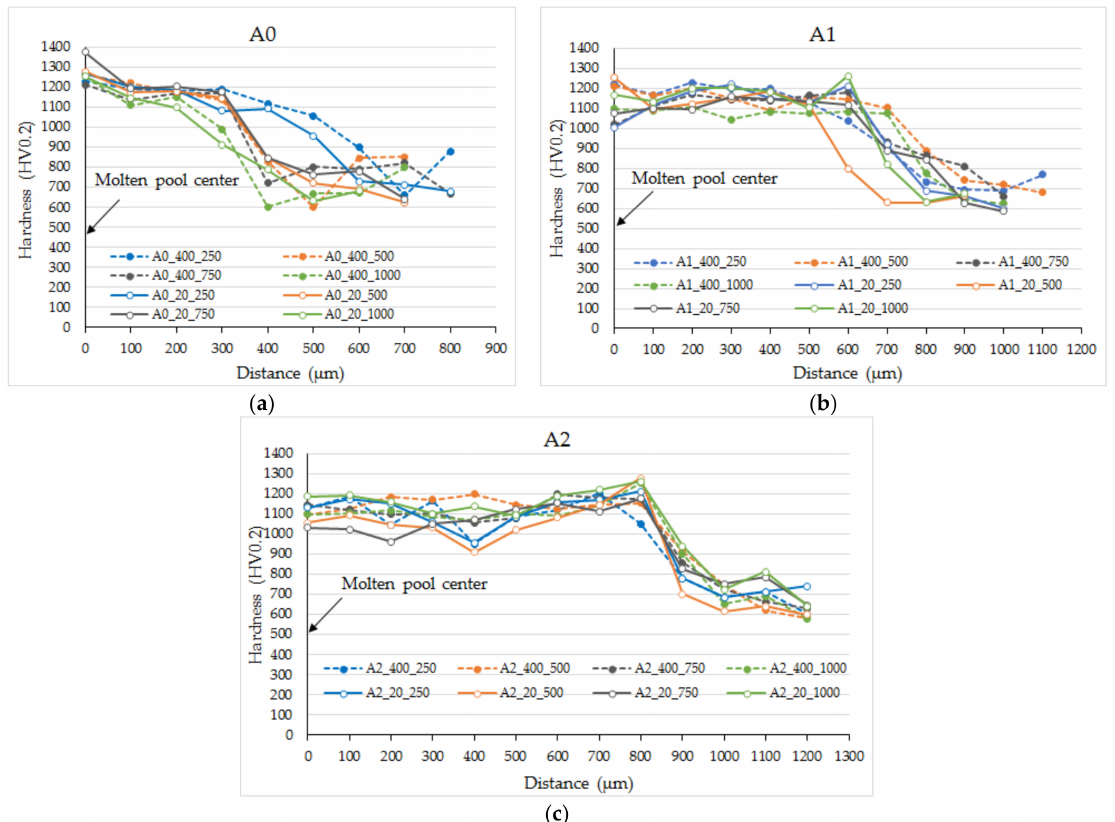
Figure 13. Hardness HV0.2 distribution across molten pool width: 250, 500, 750, 1000—indicates laser speed; 20 and 400—preheating temperature; A0, A1, and A2—0 mm, 1 mm, and 2 mm oscillation